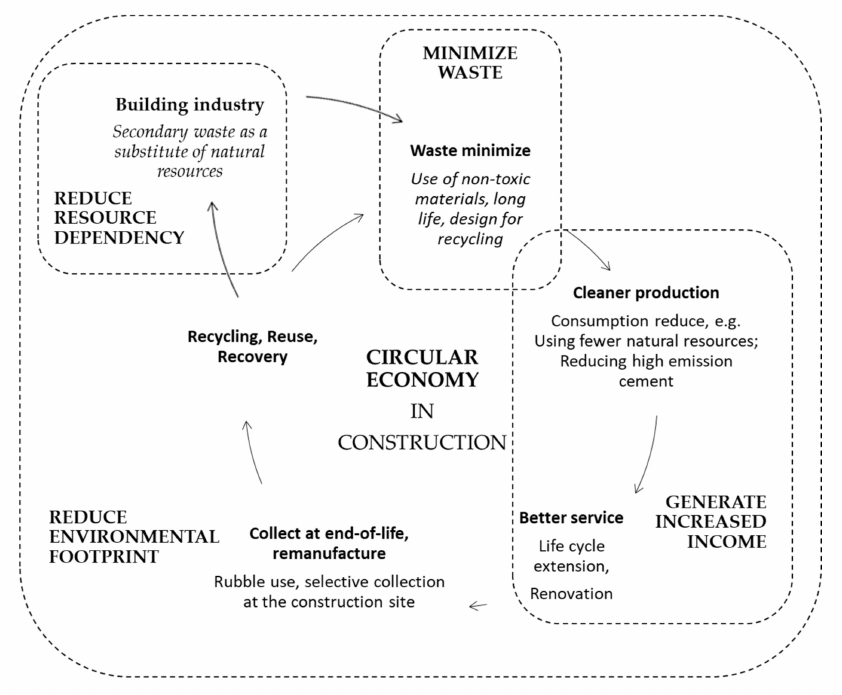
Figure 1. Circular economy in